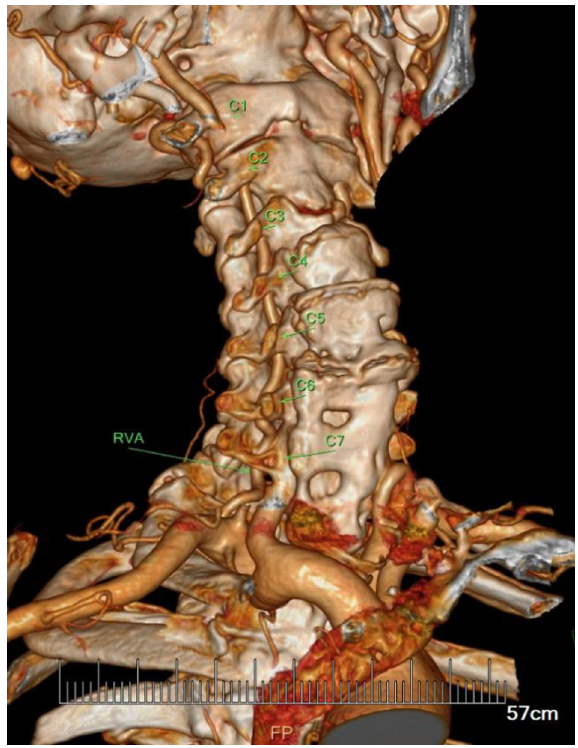
Figure 3. Typical case of the subjects with anomalous entrance at a lower level into the transverse foramen than normal (RVA: